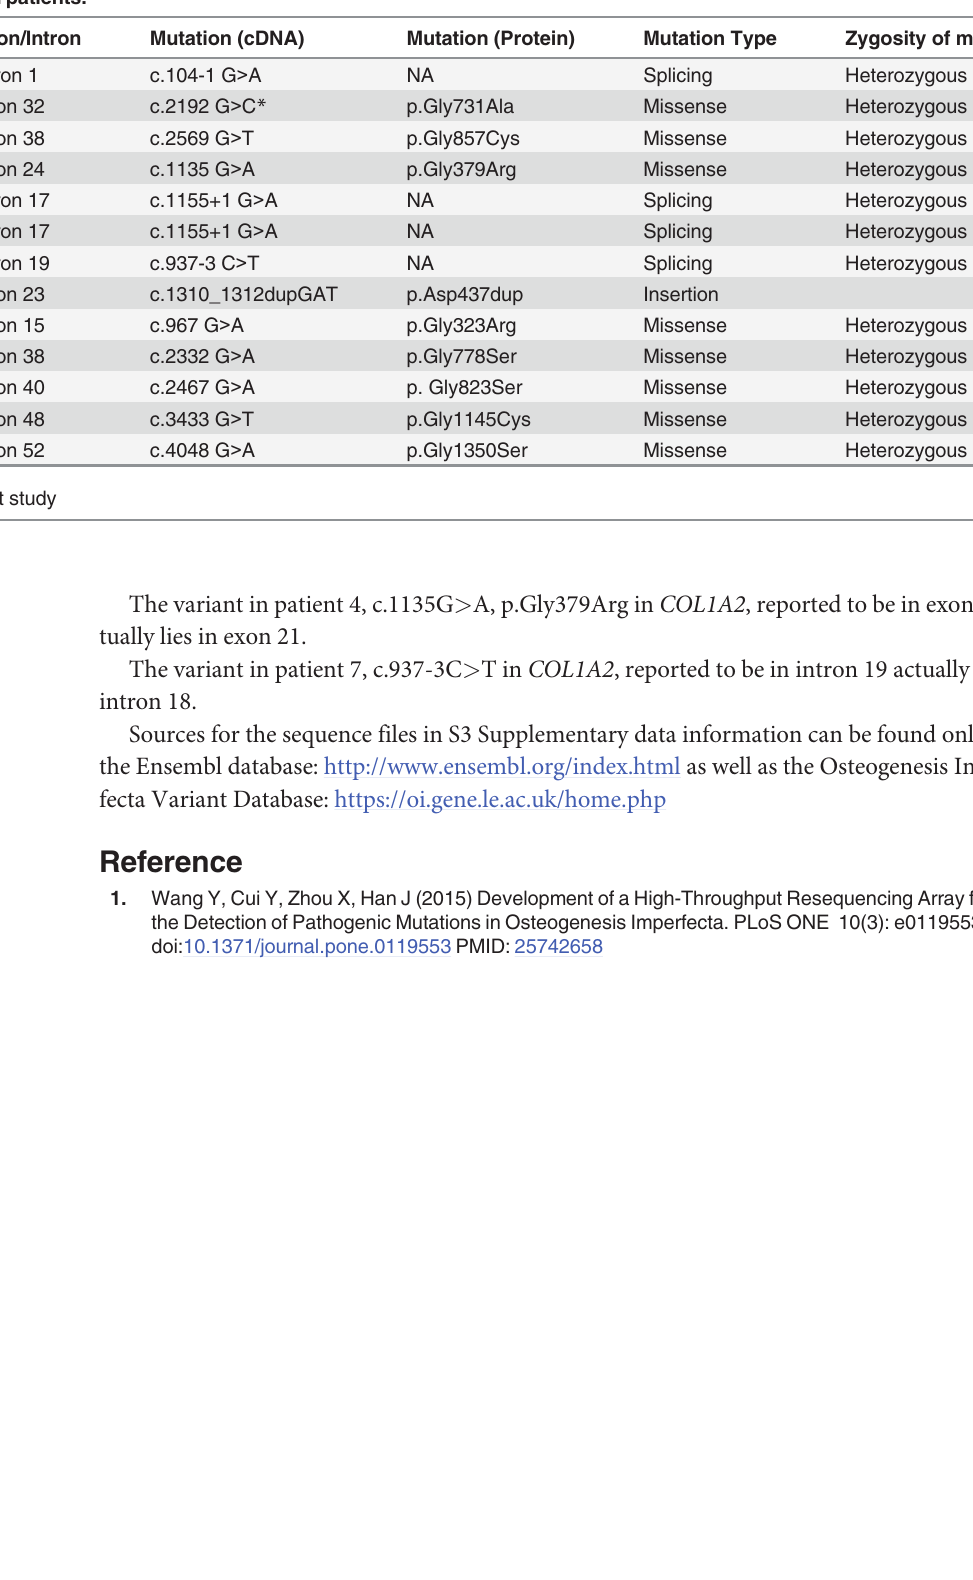
Table 2. Mutations identified in OI